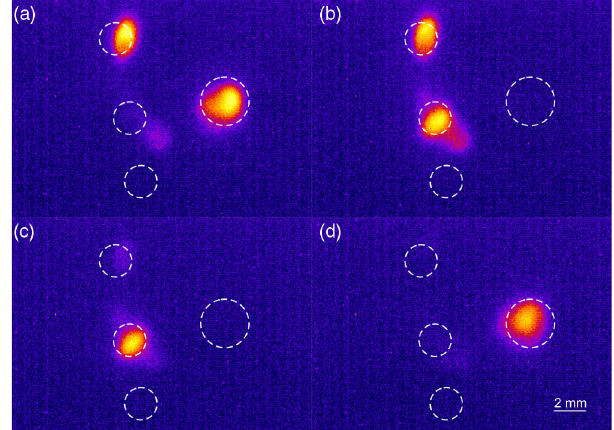
FIG. 13. Beam images obtained with the collimator for various beam